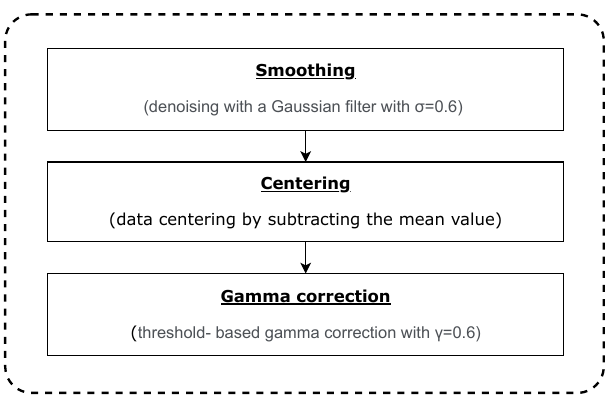
Figure 3. Flow diagram of the pre-processing steps